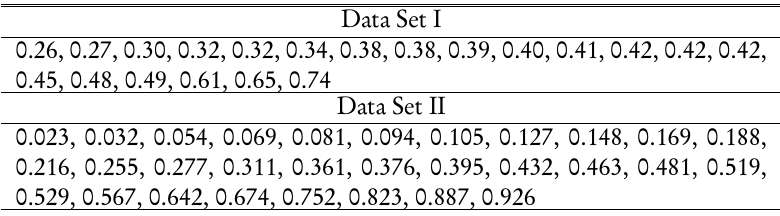
Flood level and tensile strength data